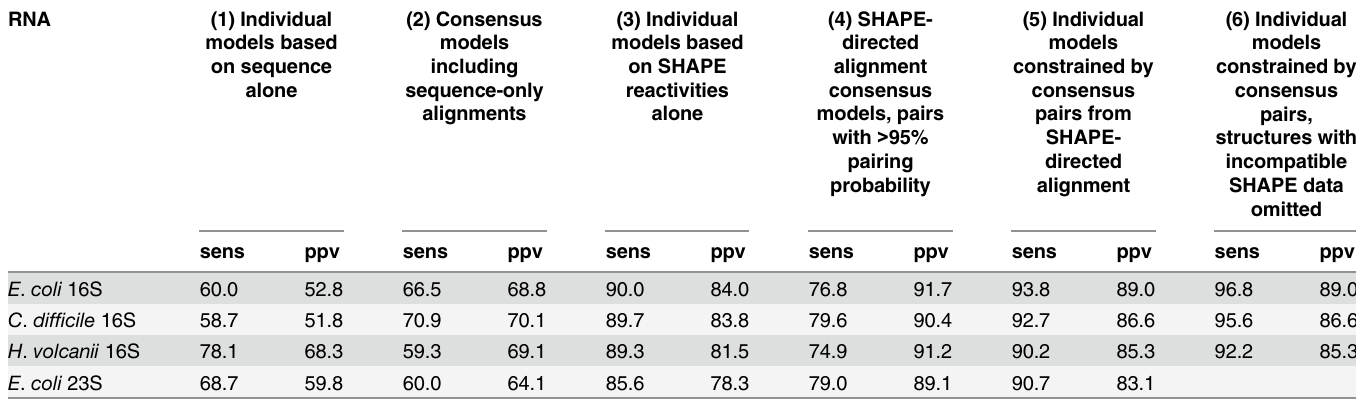
Table 2. Sensitivities (sens) and positive predictive values (ppv) for secondary structure models as a function of included information. RNA (1) Individual models based on sequence